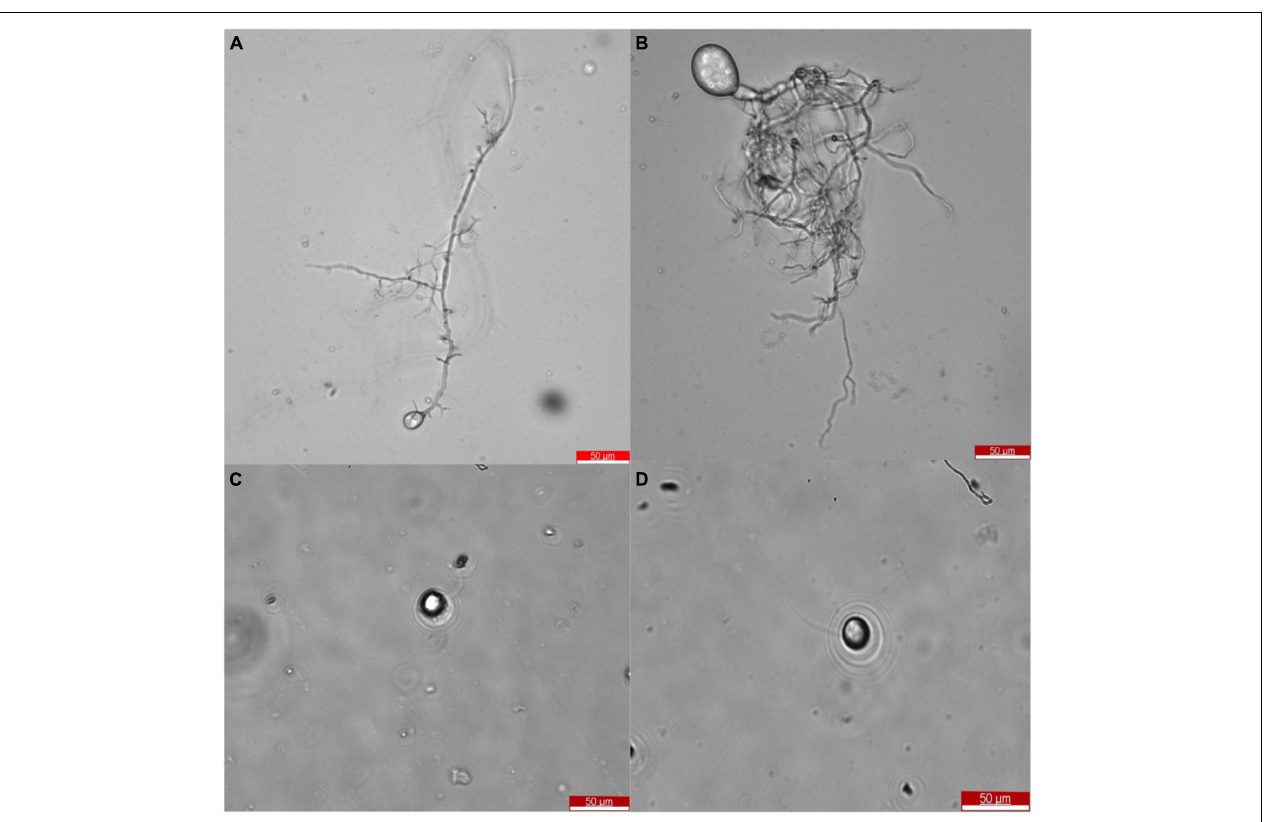
FIGURE 2 | Morphology of Oontomyces sp. CR2 (A,C) and Piromyces sp. CF9 (B,D) . Scale bar indicates 50 µ m (A,B) . TABLE 1 | Chemical composition of reed, alfalfa stalk, Broussonetia papyrifera leaves, and Melilotus officinalis . Substrate